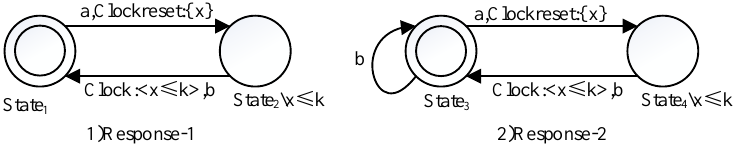
Figure 4. Property pattern of Response.